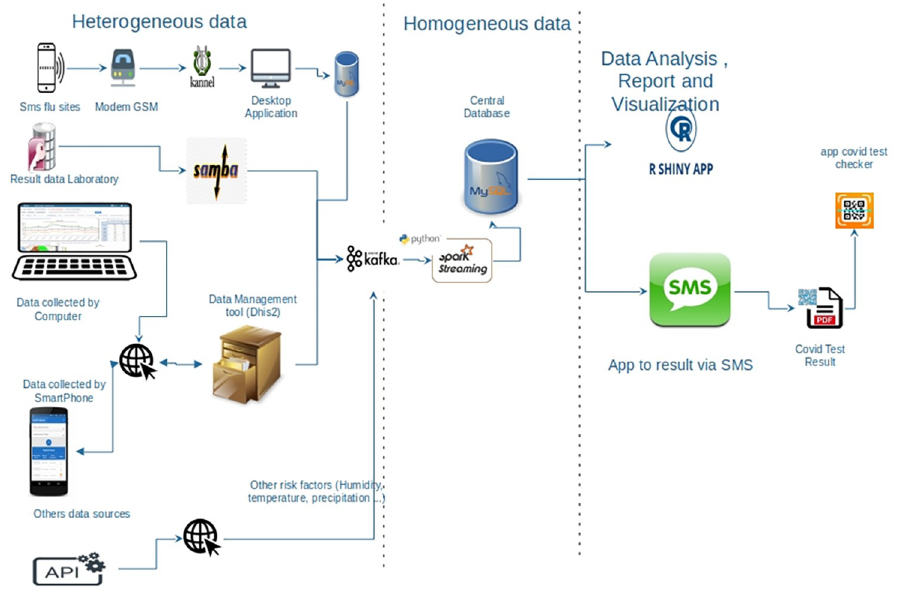
Fig 2. Architecture of PlaCARD for COVID 19 diagnostic data management and test